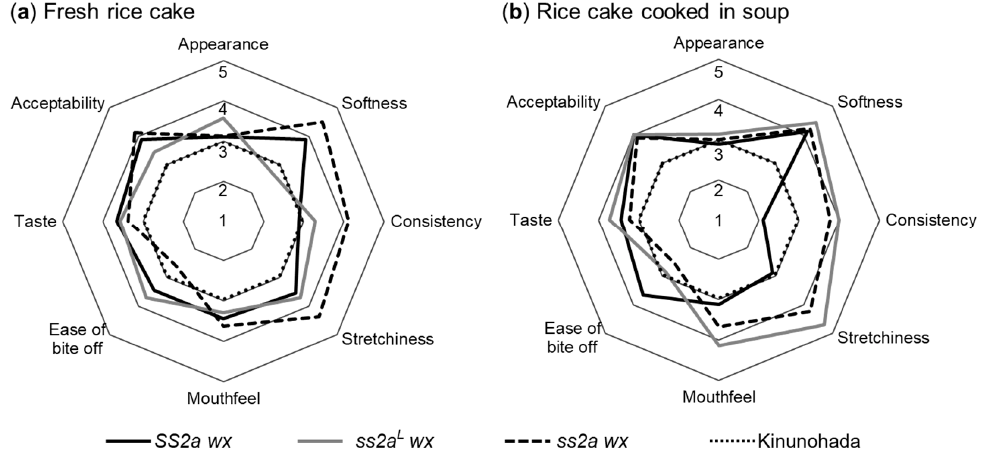
Figure 8. Sensory evaluation of rice cakes by panelists. ( a , b ) Evaluation of fresh rice cakes ( a ) and rice cakes cooked in soup ( b ) on a 5-point hedonic scale by at least seven panelists. Data represent mean of at least seven panelists. The commonly consumed glutinous rice cultivar Kinunohada was used as a control, and its score was set at three.